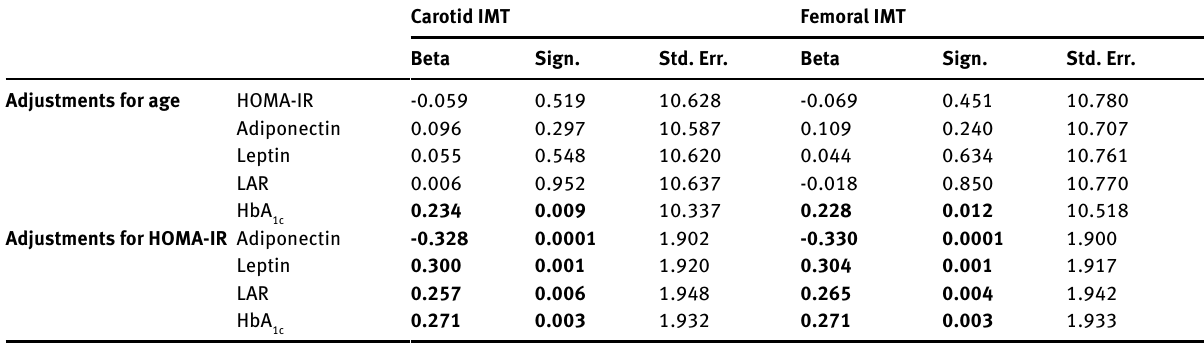
Table 5: Multiple linear regression models: the relationships between IMT and the metabolic parameters adjusted for age and HOMA-IR